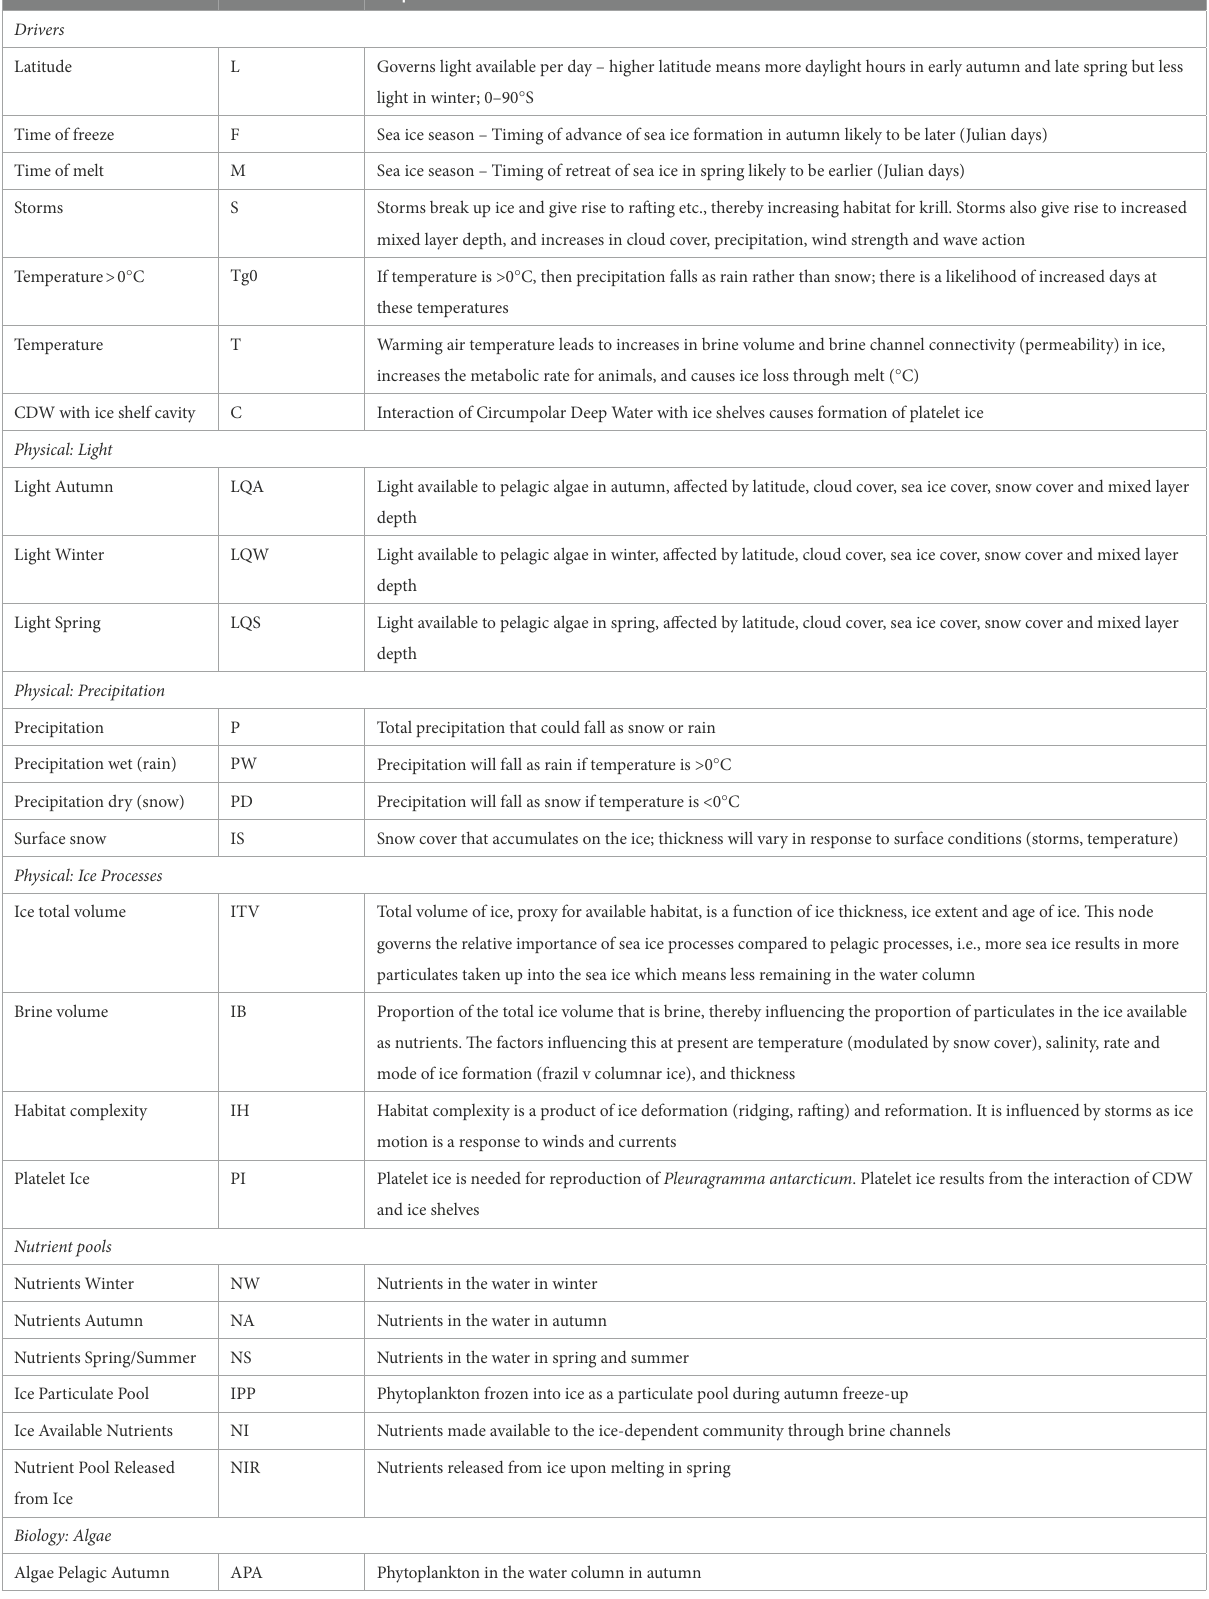
TABLE 2 Description of the nodes used in the qualitative network model, as displayed in Figure